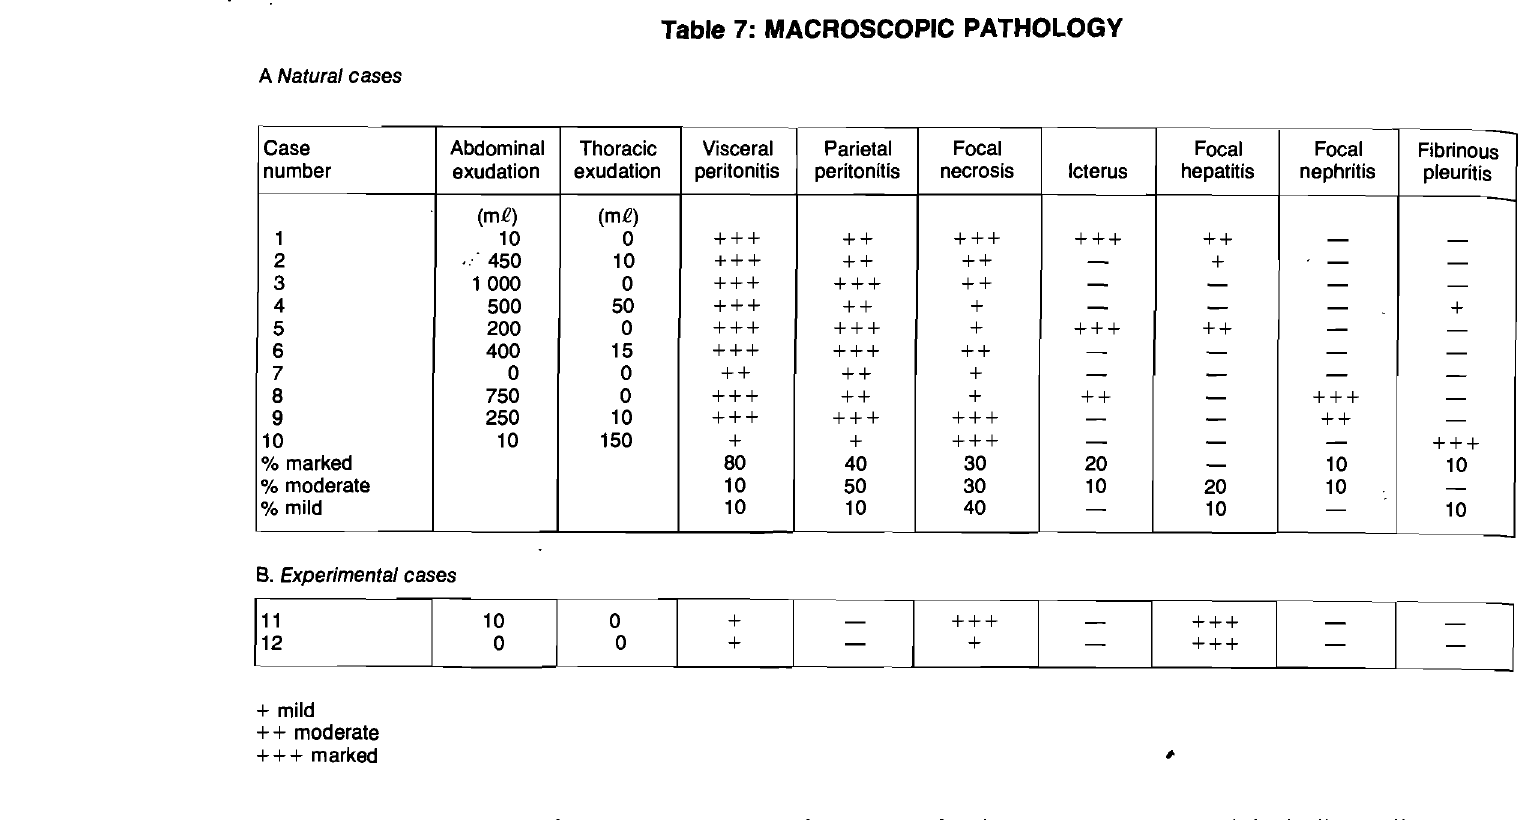
Table 7: MACROSCOPIC